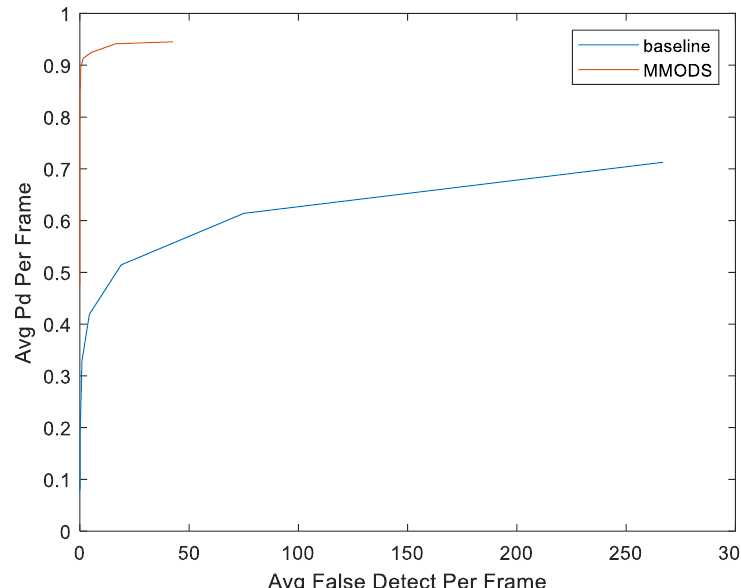
Figure 9. ROC curve comparison using simulated data.